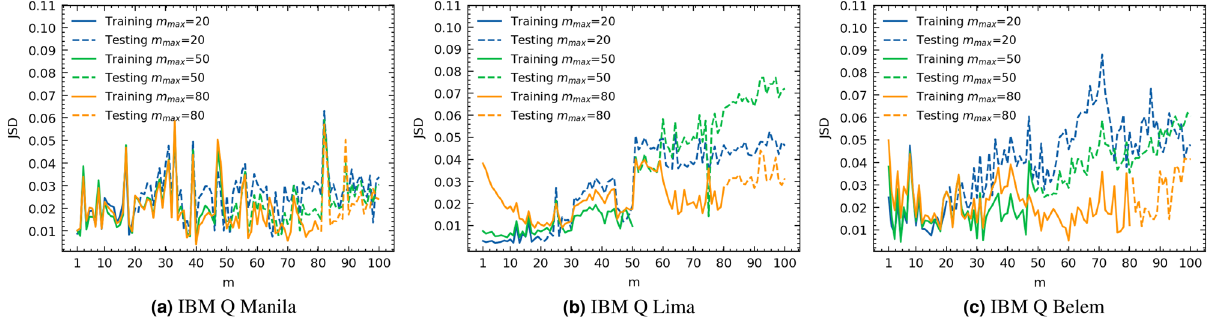
Figure 1. JSD ( ˆ q ( m , | 0 � ) , q ′ ( m , | 0 � )) for training sets of depths T and testing sets of depths T ′ with variable